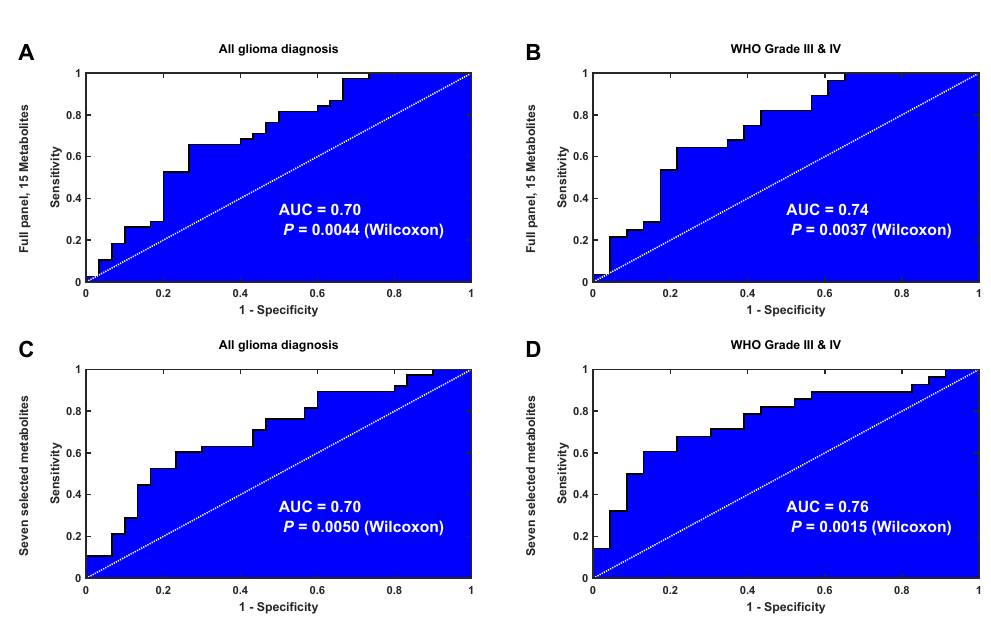
Figure 7. ROC curve analysis of the latent biomarker predicting glioma detection eight years before diagnosis in the single time point data set. ( A ) ROC curve for all glioma diagnoses using all 15 metabolites identified by SMART. ( B ) ROC curve for high-grade glioma diagnoses only using all 15 metabolites, as in ( A ). ( C ) ROC curve for all glioma diagnoses using a subset of seven metabolites identified with a strong and consistent significance pattern by SMART. ( D ) ROC curve for high-grade glioma diagnoses only using the same seven metabolites, as in ( C